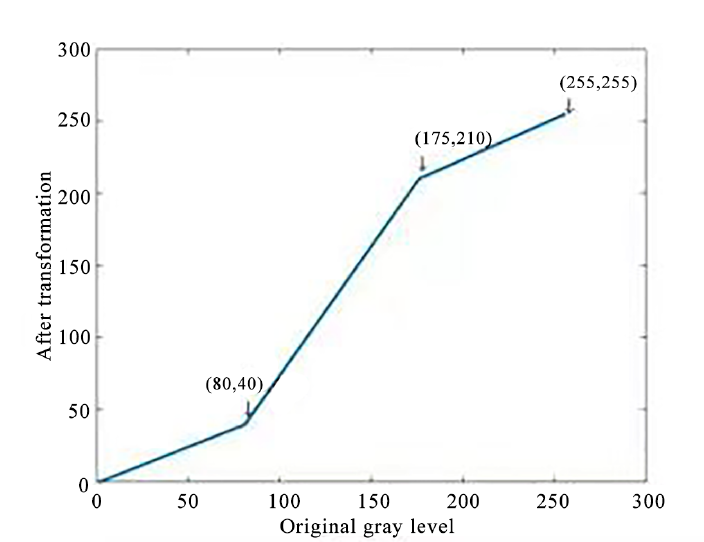
Figure 9. Gray-scale restricting rule.